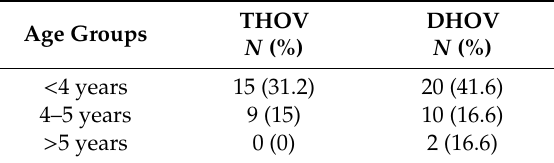
Table 5. Seroprevalence with respect to animal